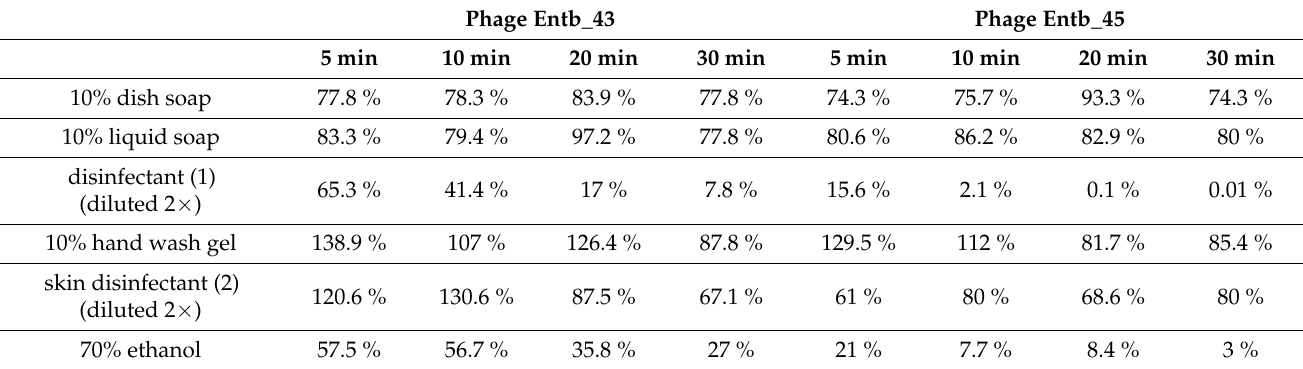
Table 8. Percentage of phages retaining activity after specified intervals of incubation with various disinfectants.